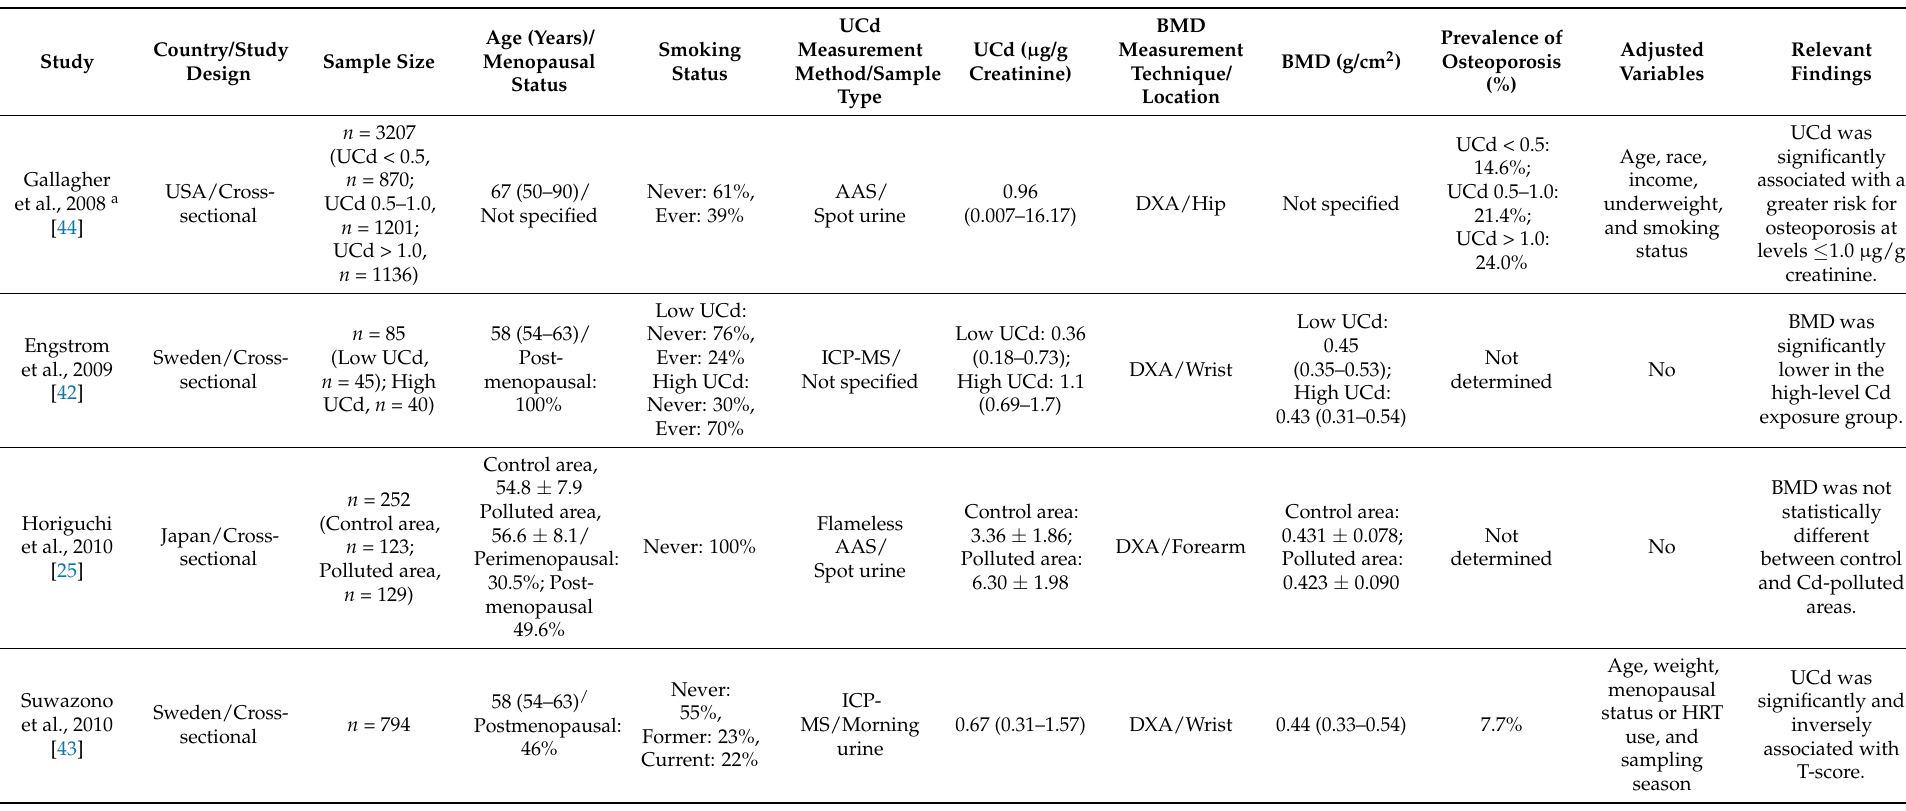
Table 1. Characteristics of studies included in the systematic review and meta-analysis evaluating the effects of environmental cadmium exposure on bone mineral density or osteoporosis in women aged 50 and older from 2008 to